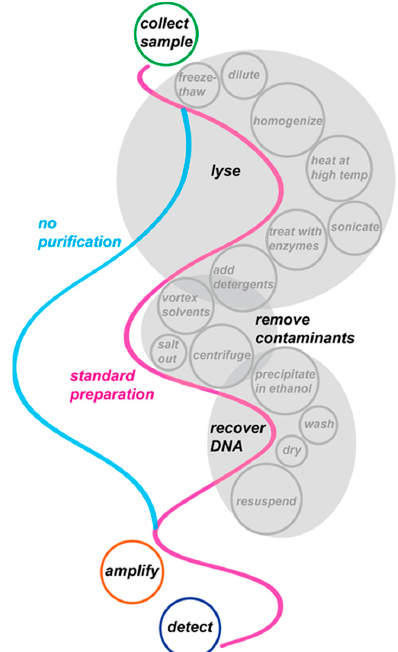
Figure 1. Direct nucleic acid testing is much more convenient and streamlined than the three-step method with preparatory techniques. In a typical extraction experiment, buffer with lytic agents is added to dilute the sample and homogenized with a mixer. Sonication creates pressure waves that burst the cells in mechanical lysis. Lysozyme enzymatically destroys cells, and is removed from the reaction with vortexing and centrifugation in a phenol/chloroform phase separation. The DNA is precipitated in fresh ethanol and the resulting mixture is washed to remove excess contaminants. Excess liquid is removed so that the DNA can be resuspended in an appropriate buffer.